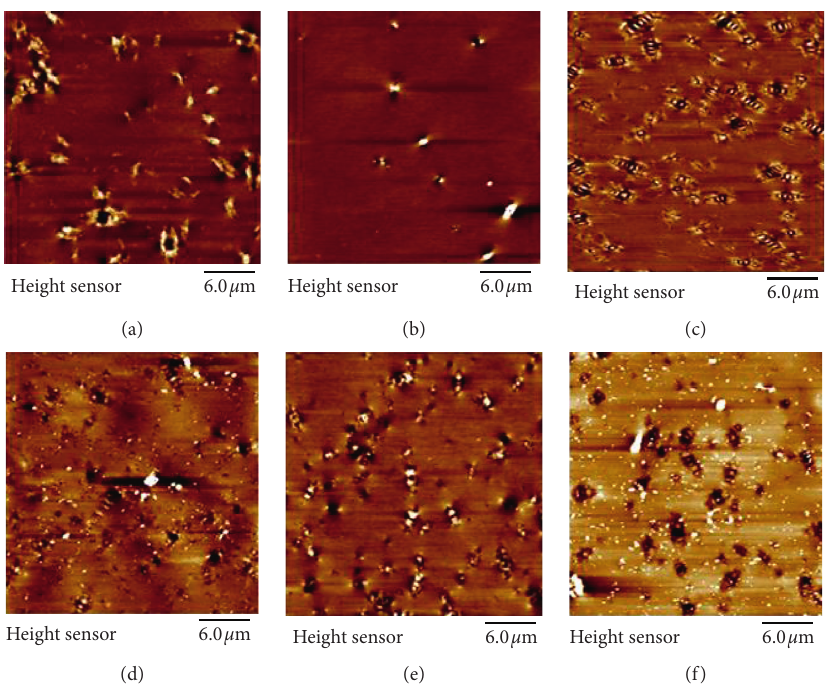
Figure 8: Two-dimensional topography images of the three asphalts: (a) SBS-modified asphalt; (b) SBS-modified asphalt after immersion; (c) OMMT A-1; (d) OMMT A-1 after immersion; (e) LDH-5; (f) LDH-5 after